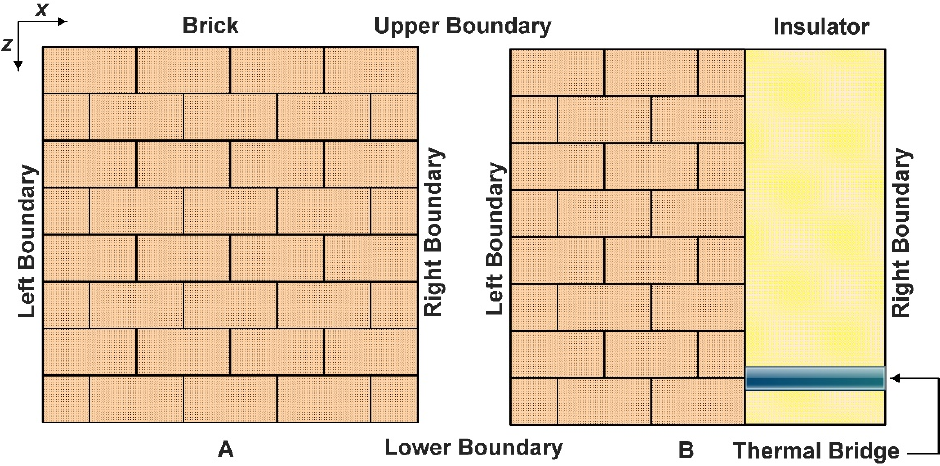
Figure 9. ( A ) surface of the wall, ( B ) wall with insulator and thermal bridge.